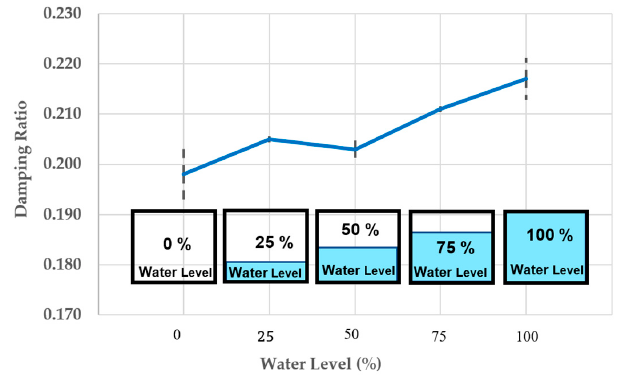
Figure 16. The change of damping.